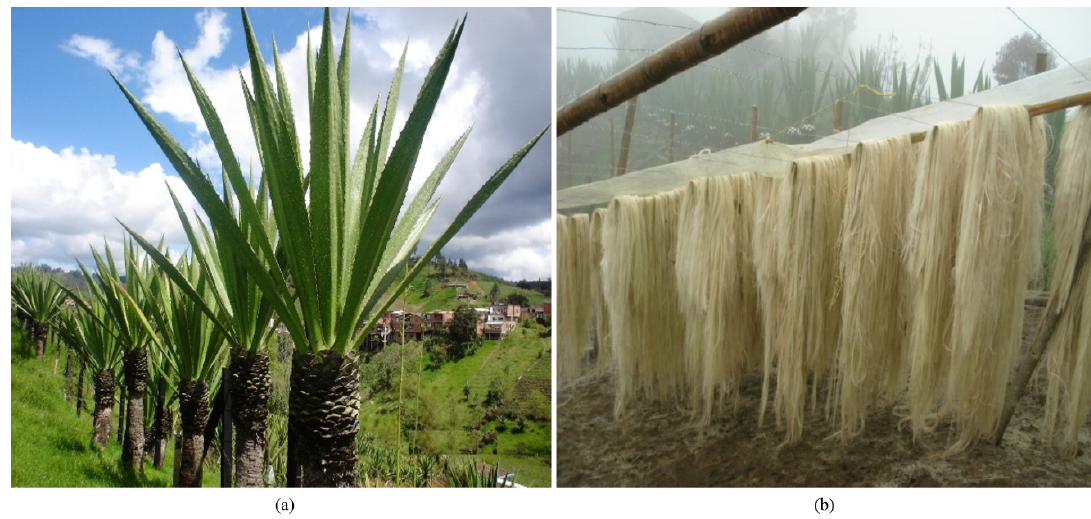
Figure 1. The fique ( Furcraea andina ): (a) cultivated plants and (b) extracted fiber drying in open air. Source: